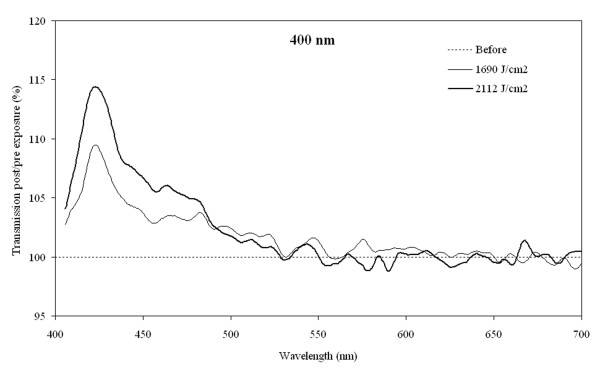
Transmission changes after 400 nm. Changes in transmission as a function of wavelength after irradiation of a 64 year old human donor lens with a 400 nm femtosecond pulsed laser for 18 h 47 minutes and 23 h and 28 minutes. The transmission before irradiation was set to 100% for all wavelengths.